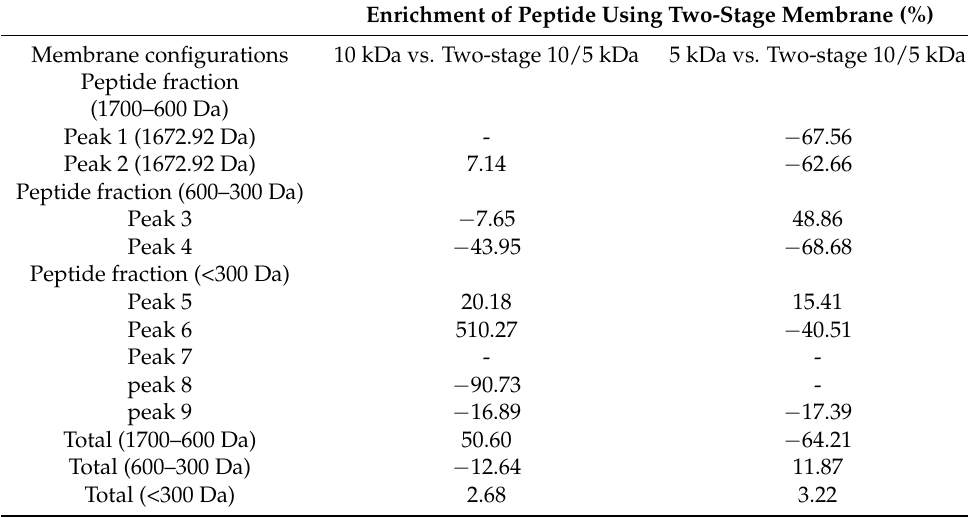
Table 2. Enrichment of peptide using two-stage membrane. Enrichment of Peptide Using Two-Stage Membrane